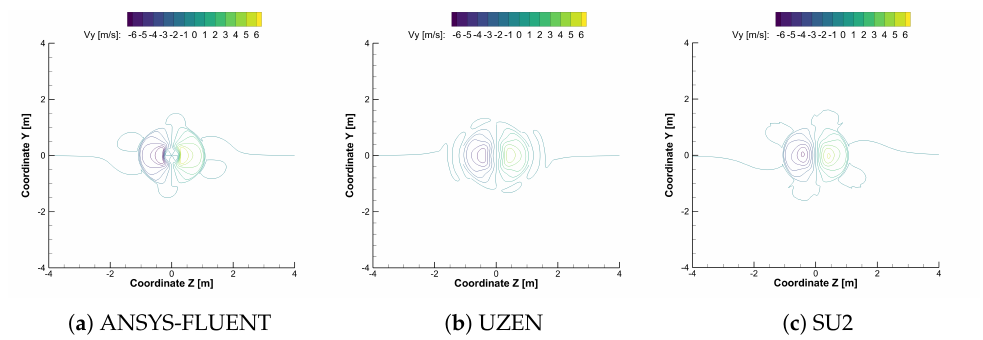
Figure 8. Comparison of y component velocity at section x = 25